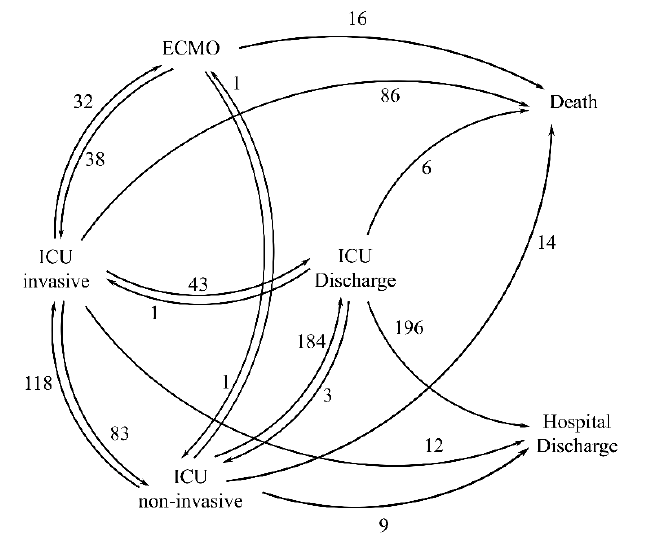
Figure 1. Multistate model representation. Each arrow corresponds to a possible transition ( n = 17). The number of events associate with each transition is shown near to the corresponding arrow. ICU = intensive care unit, ICU non-invasive: in the ICU without mechanical ventilation; ICU invasive: in the ICU with mechanical ventilation, ECMO: extracorporeal membrane